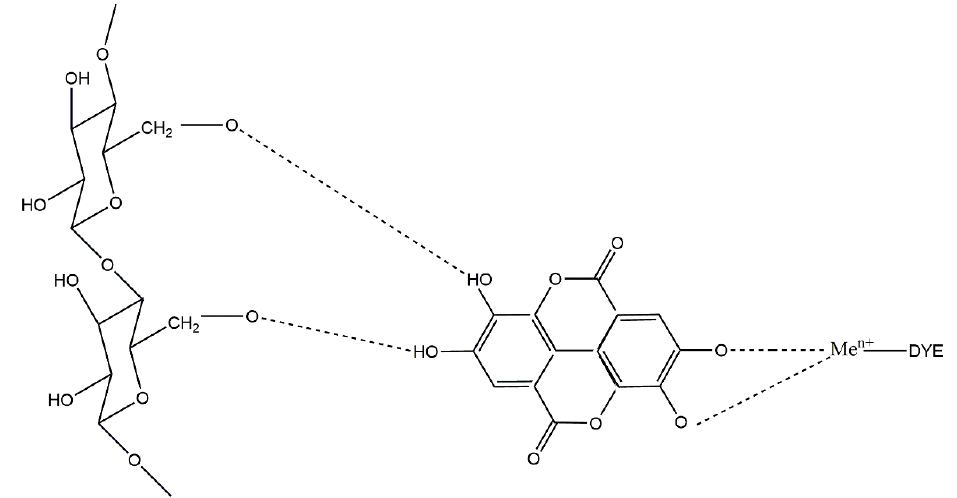
Figure 1. Mechanism of cellulose with tannin, metallic mordants, and dye.